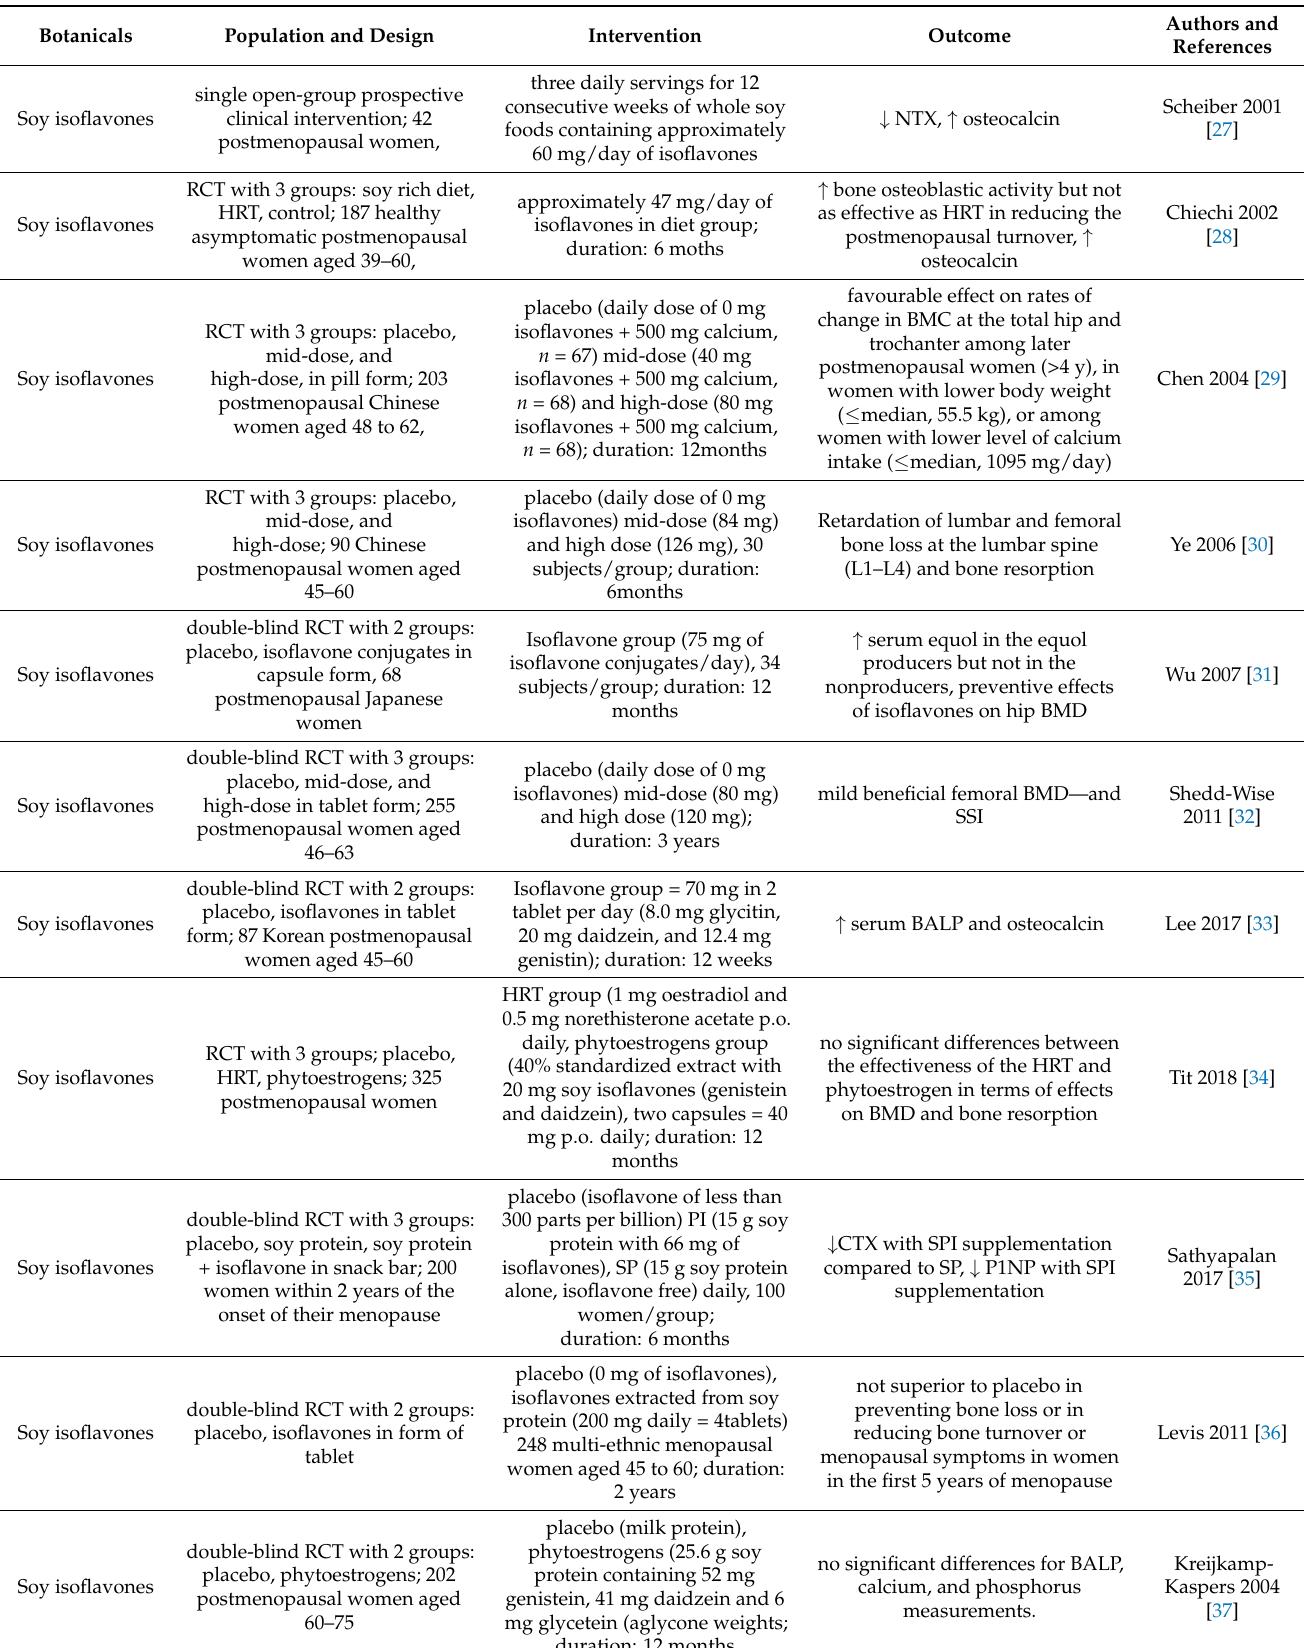
Table 2. Summary of potential anti-osteoporotic properties of botanicals in clinical trials.